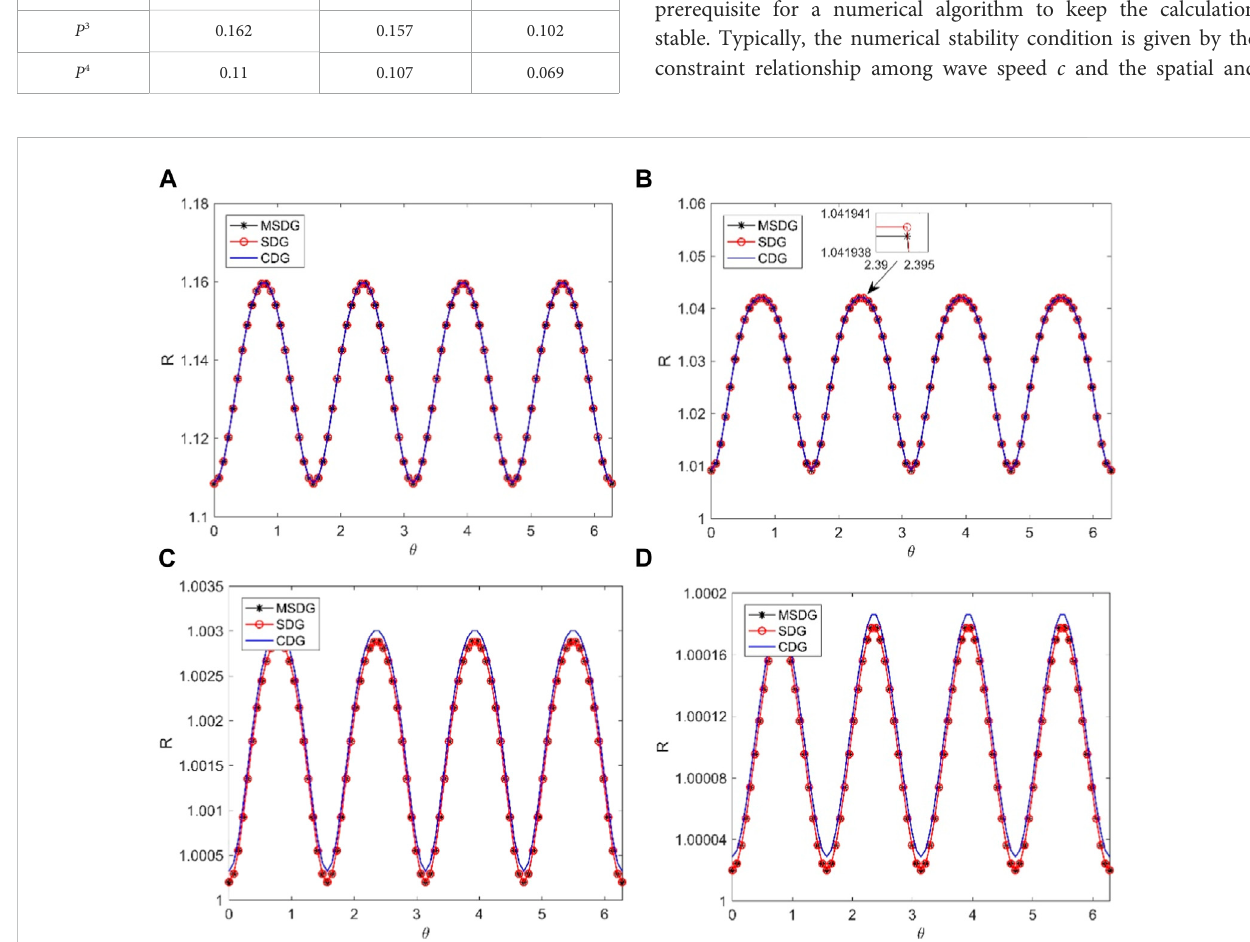
FIGURE 1 Numerical dispersion changing with the propagation direction. (A – D) : κ = 1~ 4.